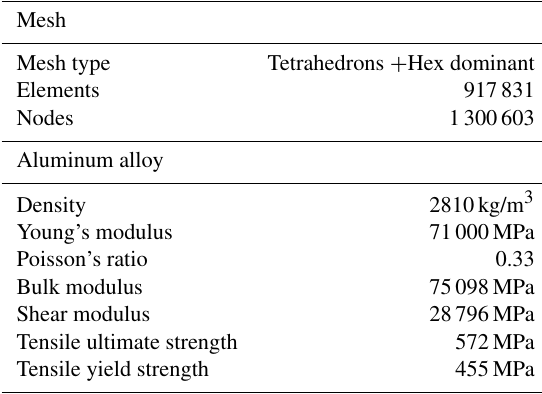
Table 3. Working conditions.